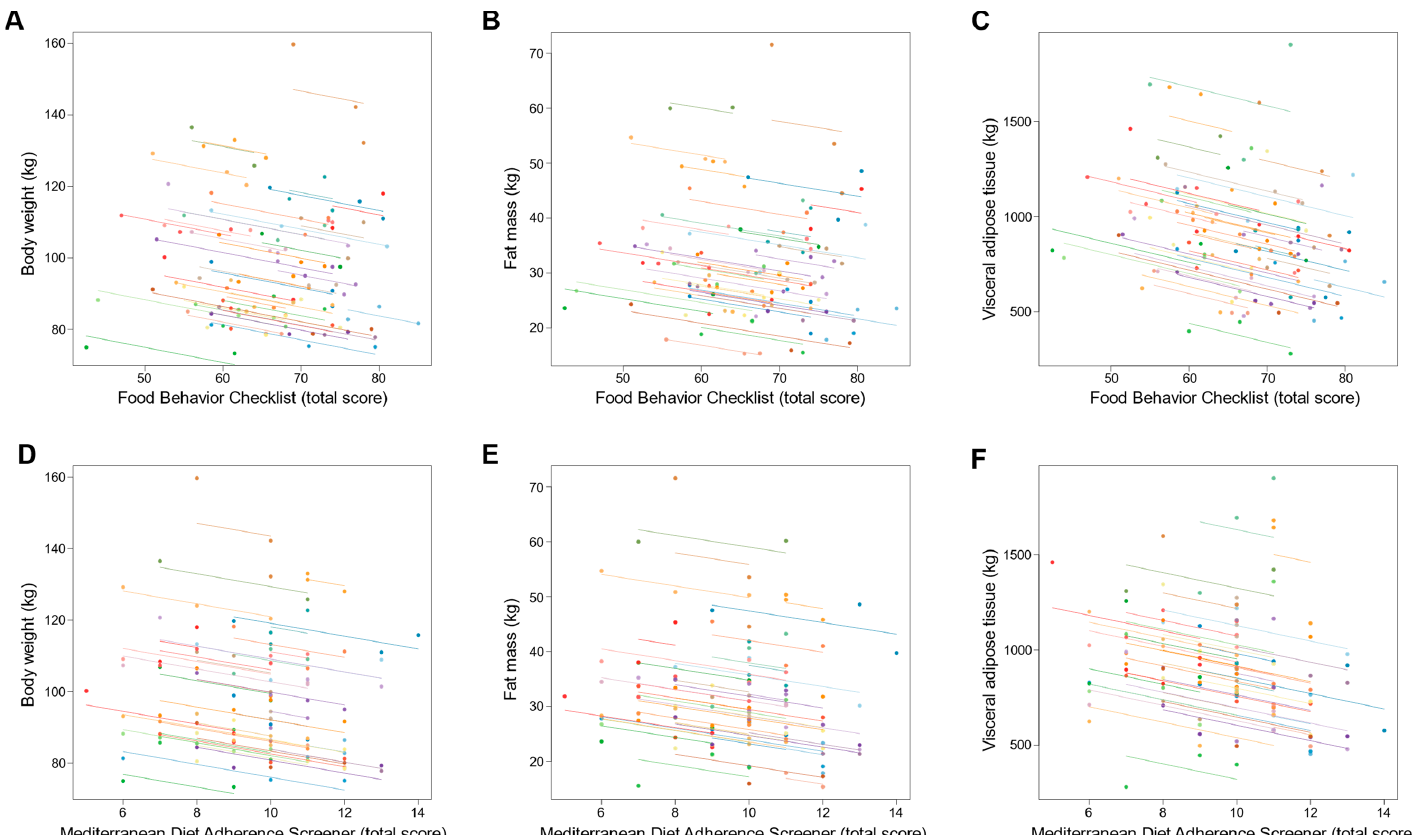
Figure 4. Association of changes in dietary behavior over time with changes in body weight and composition outcomes. Each dot represents one of three separate observations (baseline, 8 weeks and 6 months after intervention) of dietary behavior—as measured by the Food Behavior Checklist ( A – C ) and Mediterranean Diet Adherence Screener ( D – F )—and body weight and composition outcomes for a participant. Observations from the same participant are given the same color, with corresponding lines to show the repeated measures correlation fit for each participant. ( A – C ) The Food Behavior Checklist assesses dietary behavior (range, 23–85; higher scores indicate healthier dietary behavior) [45]. ( D – F ) The Mediterranean Diet Adherence Screener assesses adherence to the Mediterranean diet (range, 0–14; higher scores indicate greater adherence; scores ≥ 10 indicate high adherence to the Mediterranean diet) [46].